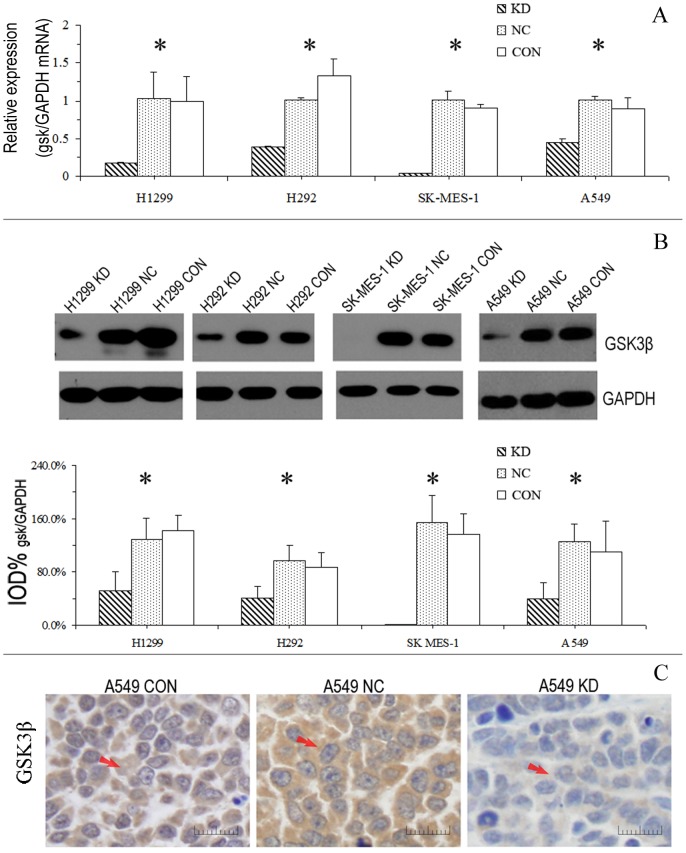
Stable silencing of GSK3β by shRNA in NSCLC cells.(A) GSK3β-specific shRNAs were transfected into NSCLC cells with lentiviral vector, and cells were harvested and counted 5 days after transfection. Real-time PCR indicated that interference by shRNA effectively knocked down the mRNA expression of GSK3β in NSCLC cells. (B) The cells were harvested and counted 7 days after transfection. Western blot shows the efficiency of protein silencing by shRNA. (C) After treatment with the GSK3 shRNA(KD group), the negative control shRNA (NC group) or normal saline (CON group), the A549 cells (1×106/ml) were injected into the backs of nude mice. Four weeks later, xenograft tumors were isolated and immunohistochemical stained. The results verified the sustained reduced levels of GSK3β in the KD group relative to the control groups. Arrows indicate positive staining in the cytoplasm of tumor cells (magnification × 400). The experiments were repeated 3 times, and the data are expressed as the mean ± SD. *P<0.001.